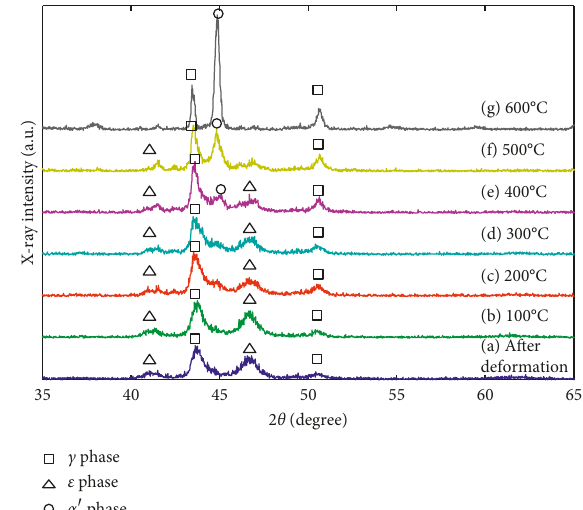
Figure 10: High temperature XRD patterns for Fe-30Mn-5.9Si- 0.1C alloy at several heating temperatures.